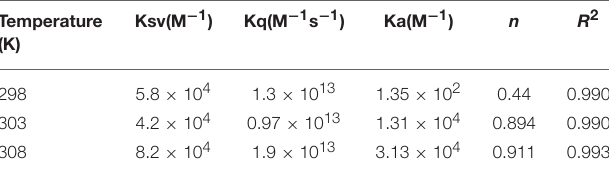
TABLE 1 | Stern–Volmer quenching constants and binding parameters for CTX-M-15 and doripenem interaction. Temperature